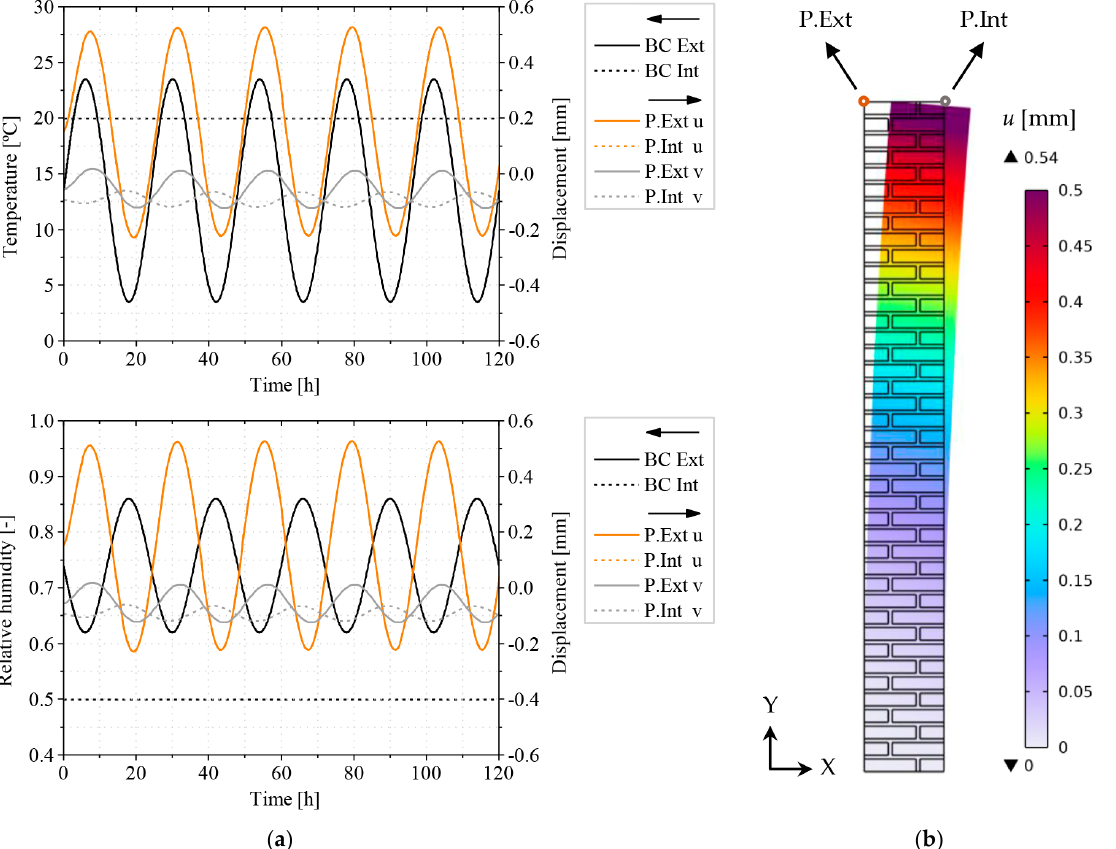
Figure 11. Hygro-thermo-mechanical analysis of the three-wythe brick masonry wall with cement mortar: ( a ) imposed boundary conditions and displacement history measured at the top of the wall; ( b ) deformed shape selected for the study (maximum horizontal displacement).